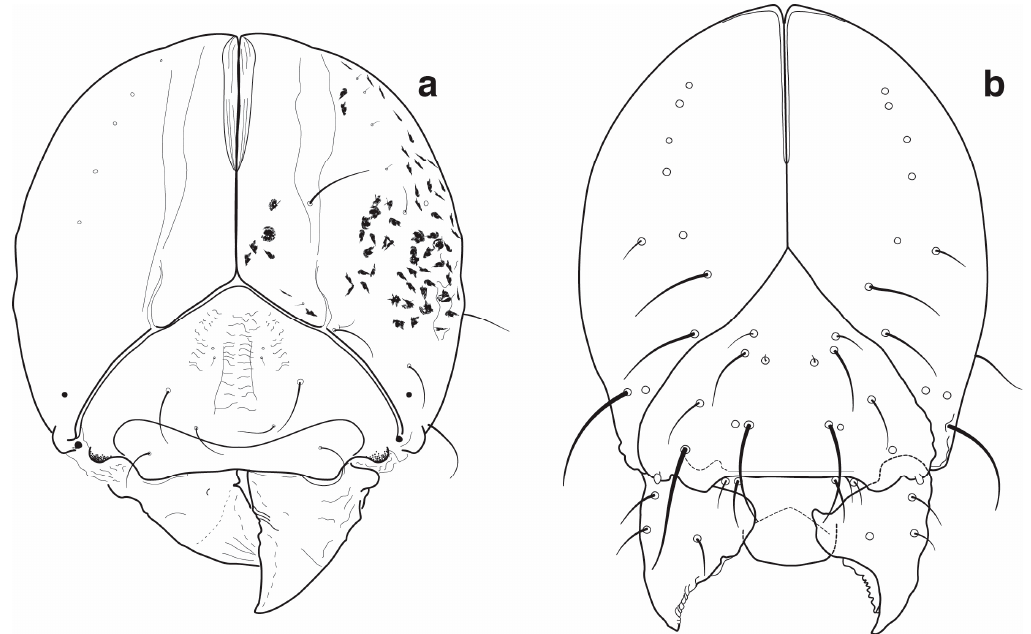
Figure 8. Head, larva, dorsal view: ( a ) Cyrtotrachelus ; and ( b ) Diocalandra .